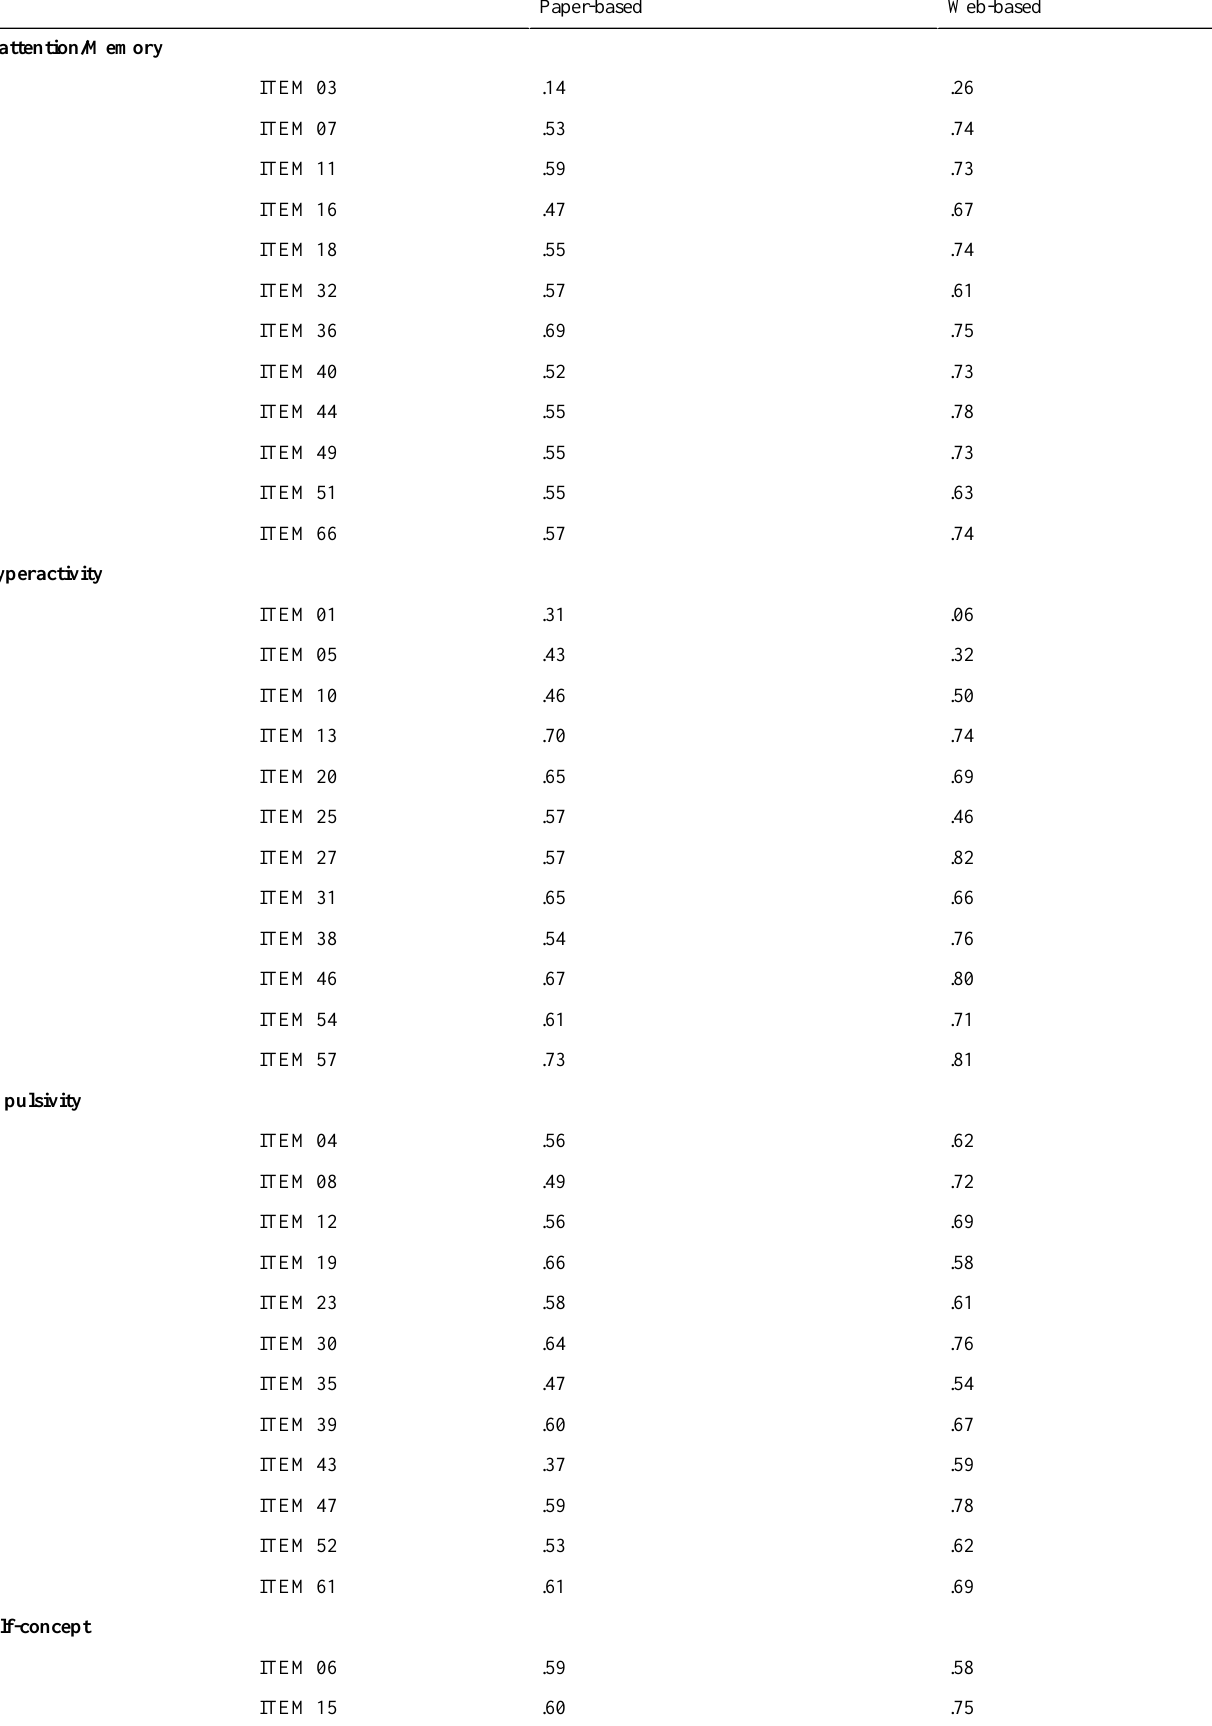
Table 2. Correlations of CAARS items (loadings) with their postulated factors (latent constructs) in the paper-based and Web-based